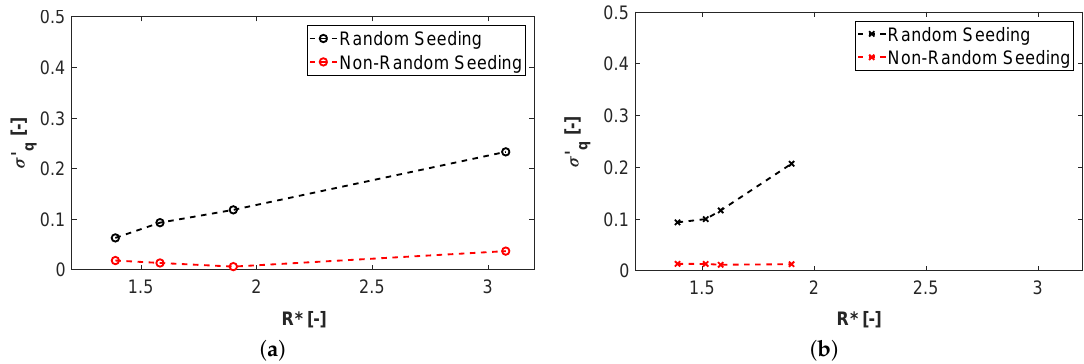
Figure 12. σ (cid:48) of q for Random Seeding and Non-Random Seeding tests. ( a ) smooth slope; ( b ) vertical